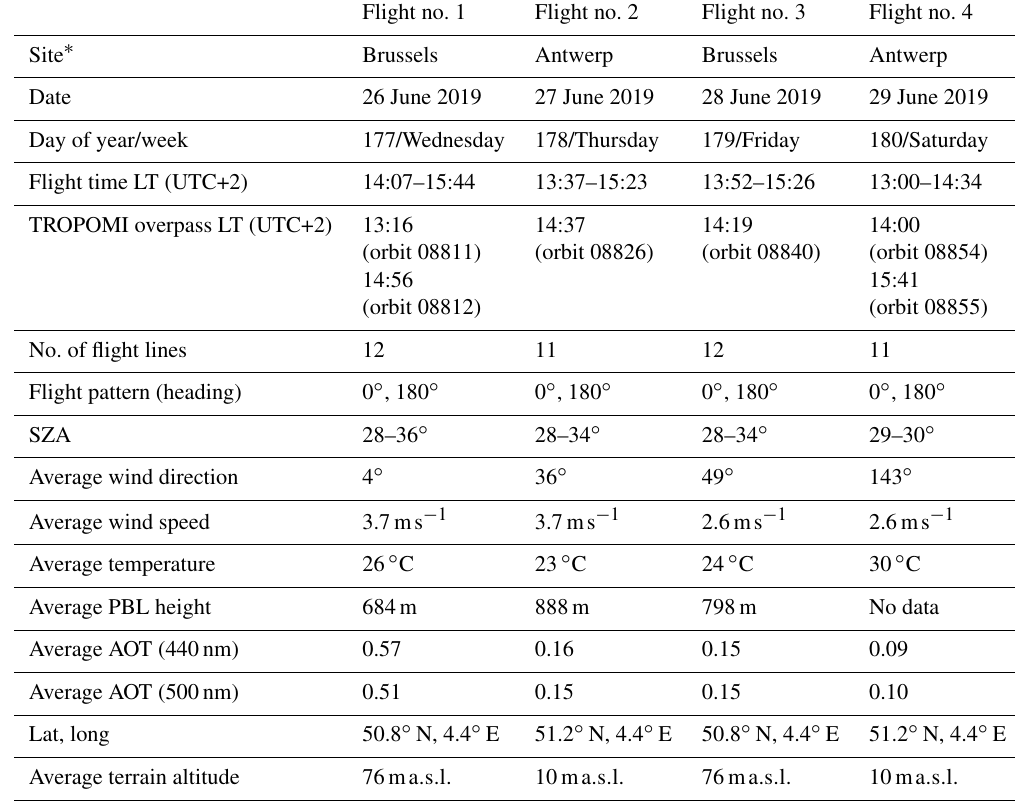
Table 1. Mapping flight characteristics, and meteorological and environmental conditions for the four APEX flights, acquired over the cities of Antwerp and Brussels, in the framework of the S5PVAL-BE